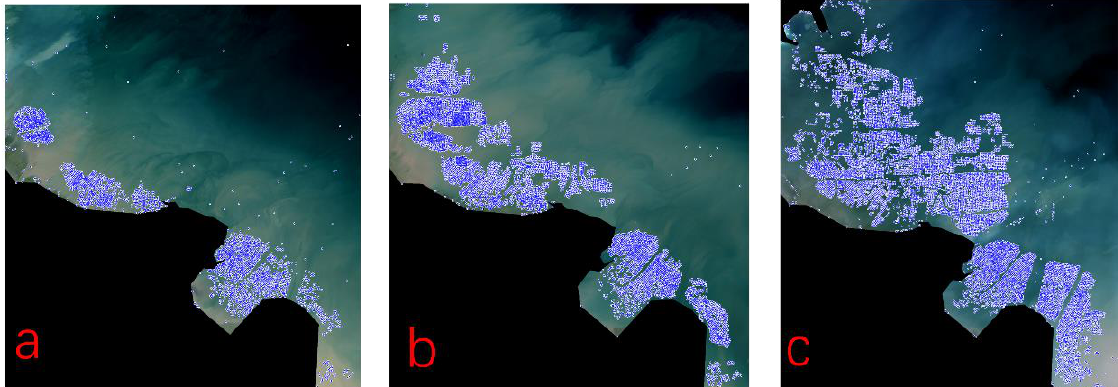
11 of 16 Table 2. Accuracy evaluation results of three different experimental areas.